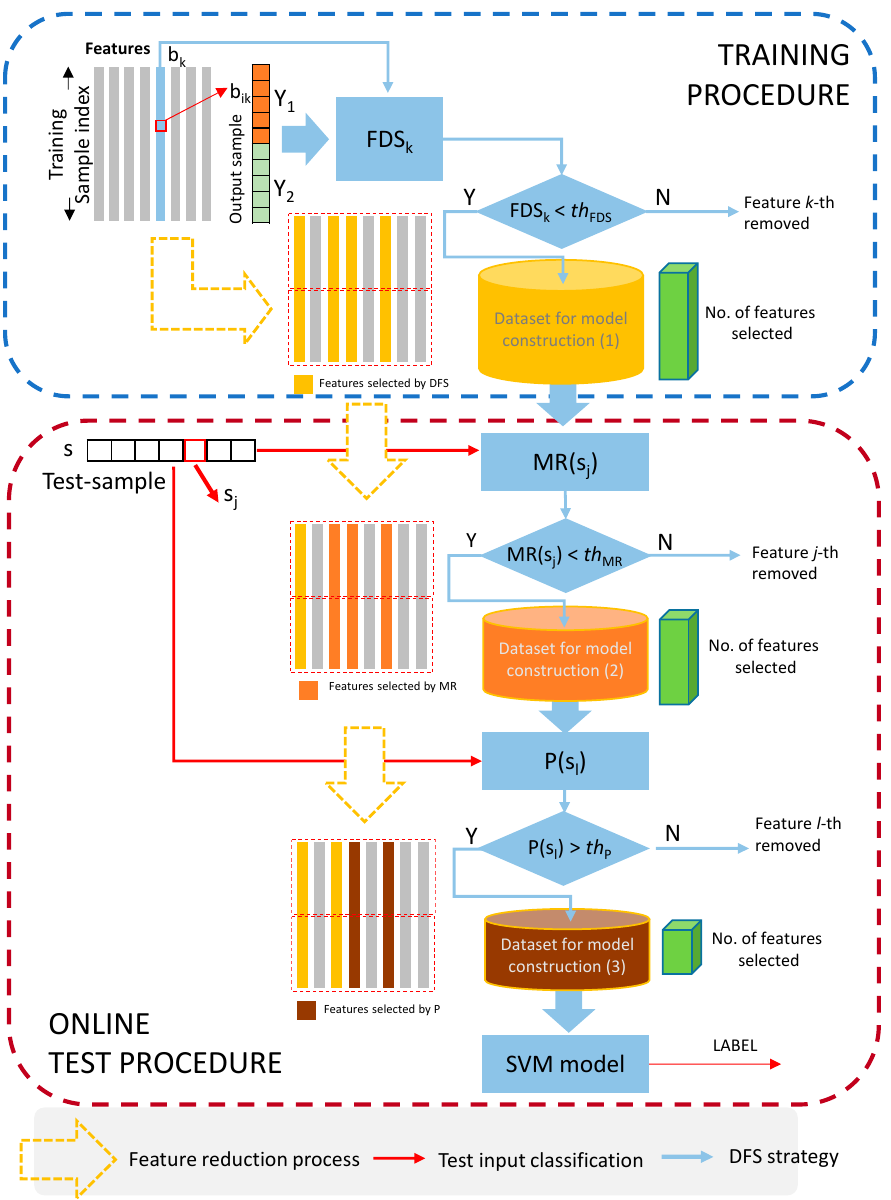
Figure 2. A schematic representation of the Dynamic Feature Selection (DFS) process.